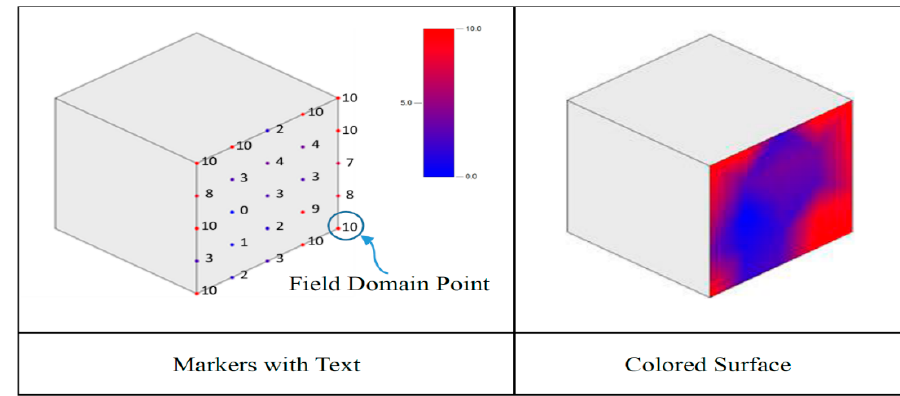
Figure 4. Revit analysis display style category function diagram.